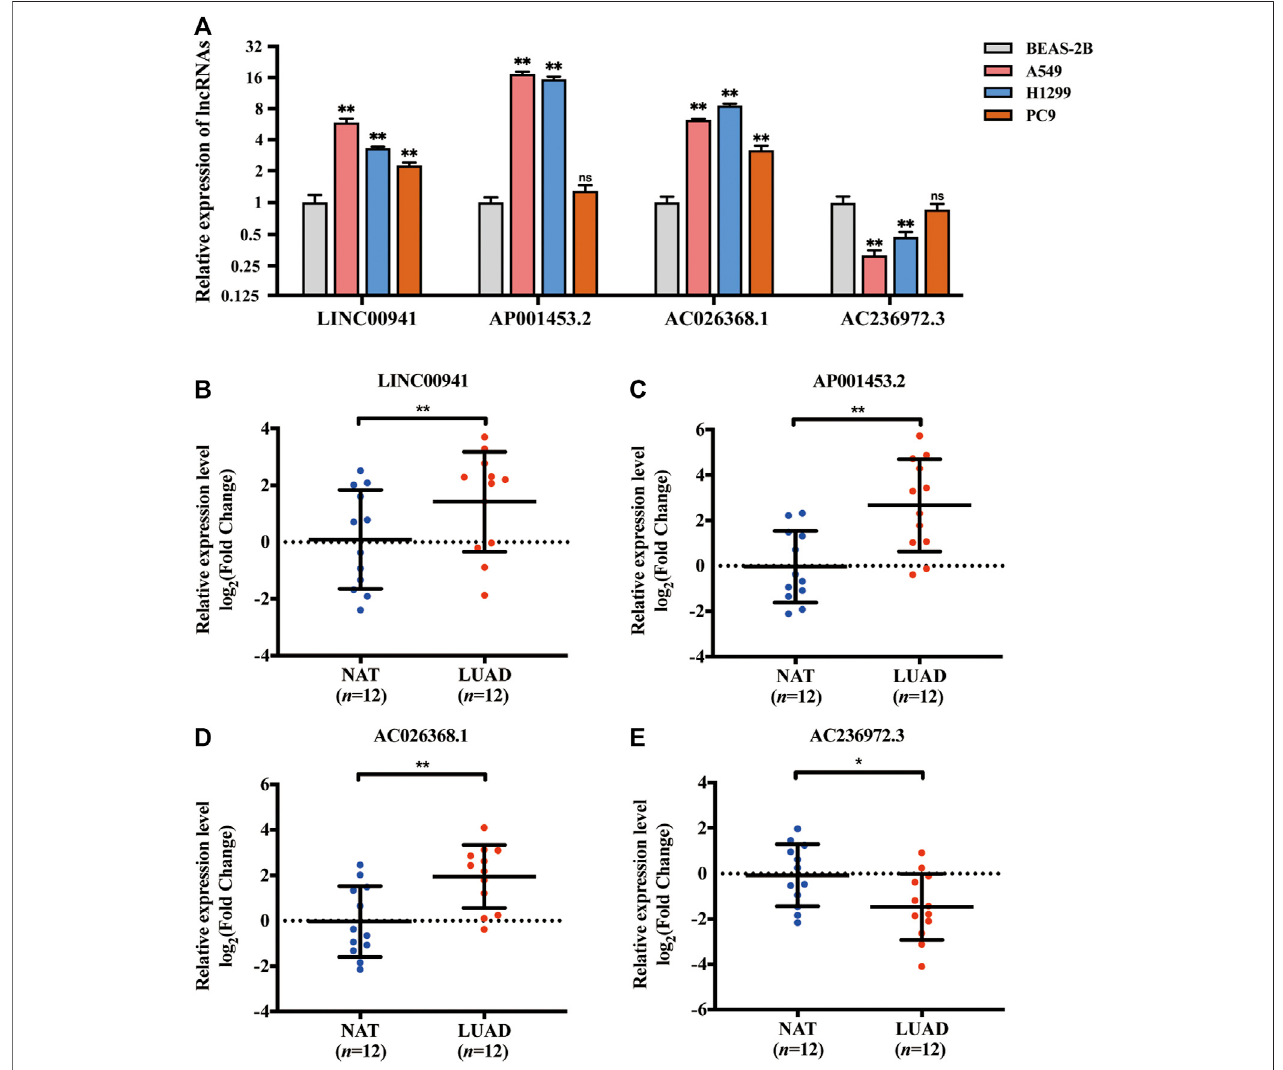
FIGURE 8 | Validation of the expression of the selected necroptosis-related lncRNA in cell lines and tissues. (A) The relative expression of 4 necroptosis-related lncRNAs in lung adenocarcinoma cell lines (A549, H1299, and PC9) with human bronchial epithelial cell line (BEAS-2B). (B – E) The relative expression of LINC00941, AP001453.2, AC026368.1, and AC236972.3 in 12 pairs of lung adenocarcinoma tissue samples. * p < 0.05; ** p <